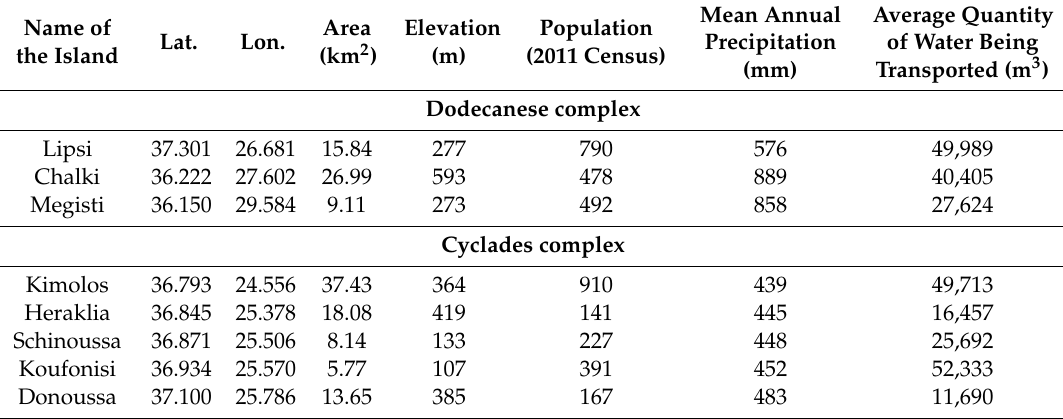
Table 2. Characteristics of the eight islands.